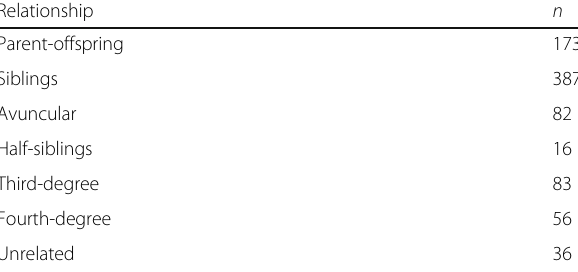
Table 2 Relationships of relative pairs included in